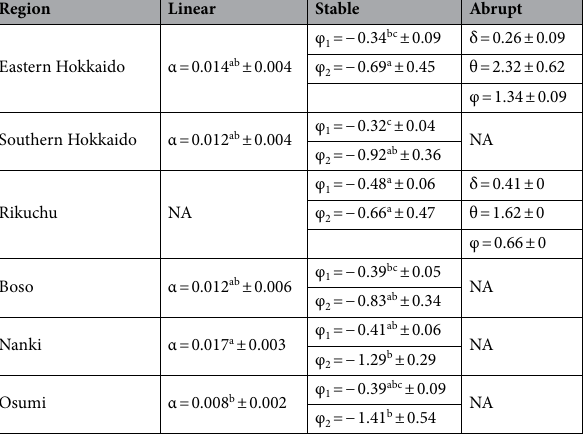
Region Linear Stable